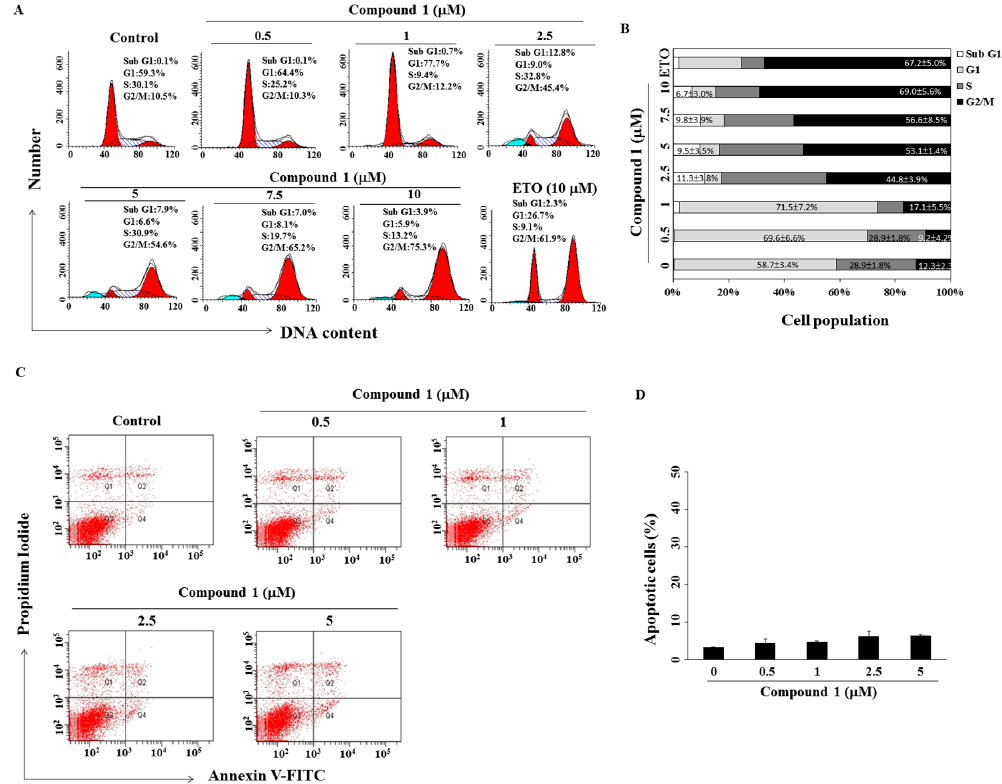
Figure 3. Compound 1 induced G2/M arrest and apoptosis in MCF-7 breast cancer cells. ( A ) Effect of compound 1 on cell cycle distribution. MCF-7 cells were treated with compound 1 at the indicated concentrations for 48 h, followed by propidium iodide (PI) staining and flow cytometric analysis. Treatment with etoposide (ETO) at 10 μ M was used as a positive control. Three independent experiments were performed; and data are presented in ( B ) as mean ± standard deviation (SD, n = 3); ( C ) the effect of compound 1 on annexin V/PI staining of MCF-7 cells for 48 h; and ( D ) the percentages in the graphs represent the percent of cells in the respective quadrants. Columns, mean; bars, SD ( n = 3).